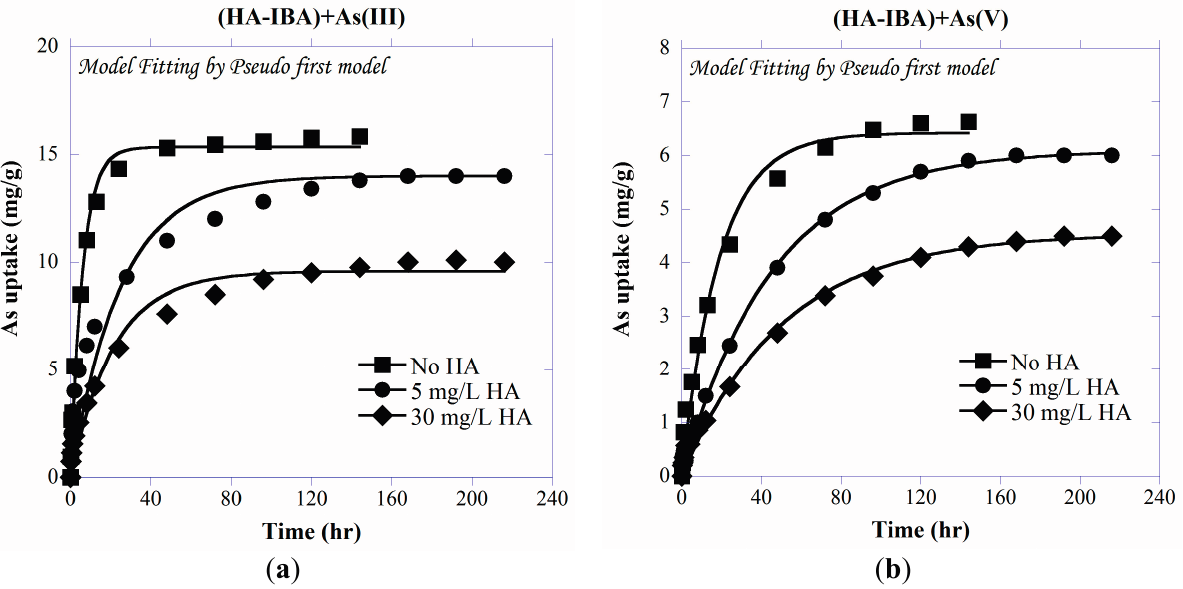
The adsorption equilibrium of As onto HA-presorbed IBA displayed relatively slow kinetics and lower adsorption capacity when compared to that onto bare IBA. As shown in Figure 10, presence of HA decreased the ability of As to sorb onto the IBA, causing about 14%–50% and 5%–15% more As(III) and As(V) to remain in solution with 5 and 30 mg/L HA compared with the As and IBA only system. Figure 10. Kinetic adsorption of ( a ) As(III) and ( b ) As(V) on IBA preloaded with different concentrations of HA and initial As concentration of 5 mg/L at pH